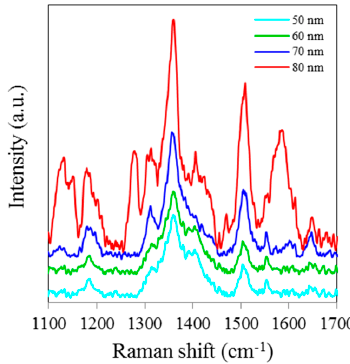
Figure 1. SERS spectra of 8 × 10 − 5 M solution of Rh6G dye adsorbed on the surface of 18 nm NAAO substrate coated with 50, 60, 70 and 80 nm gold films measured with a single scan averaging and an integration time of 3 s.